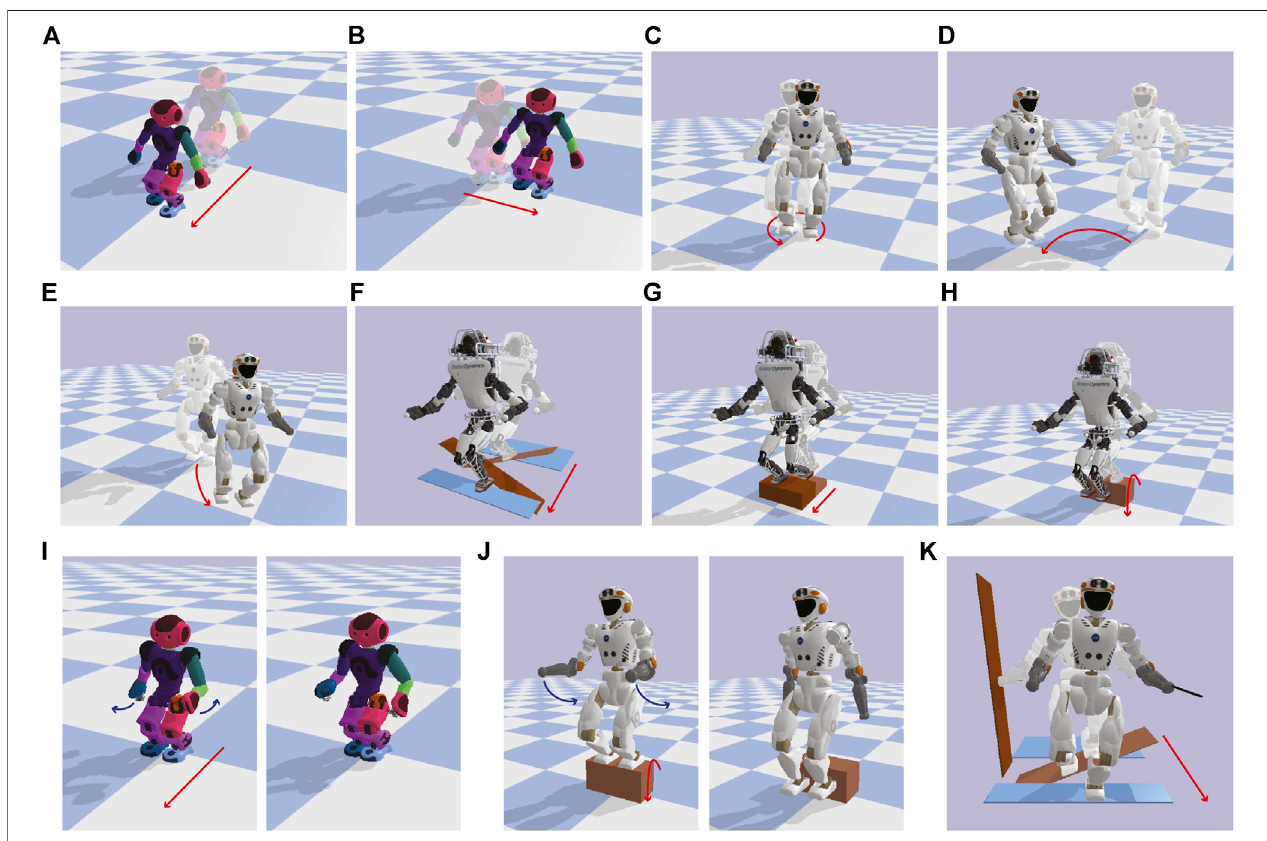
FIGURE6 | Various motions generated with TOWR+ using differentrobots areillustrated; (A) Forward walking, (B) side walking, (C) turning, (D) side walking while turning, (E) forwardwalkingwhileturning, (F) clutteredterrainrunning, (G) stairclimbing,and (H) hoppingdownablock. (I) and (J) illustrateforwardwalkingandhopping down behaviors, while performing arm motion optimizations. (K) demonstrates cluttered terrain walking of Valkyrie while making multi-contact motion using its hands. For visualization we solve the robot ’ s inverse kinematics using the trajectories computed by TOWR+ and display the resulting joint motions.